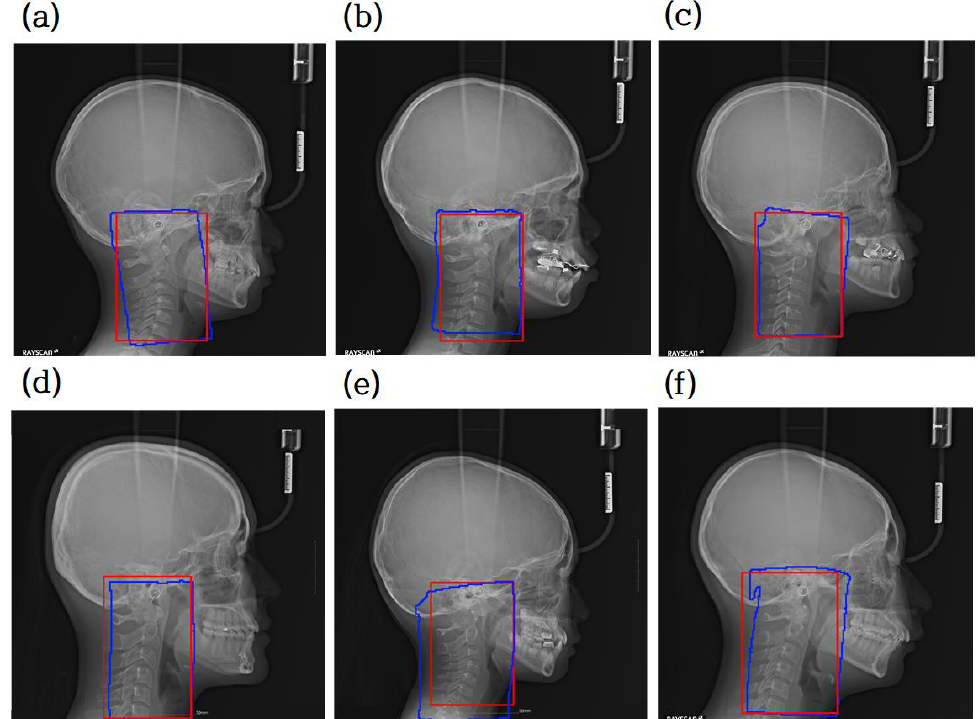
Figure 5. Comparison between ground truth of segmentation mask for extracting the region of interest (ROI) and prediction mask. Red is the ground truth, while blue is the predicted result. ( a – d ) are examples of accurate ROI detection of cervical vertebrae area. Panels ( e , f ) are not exactly tetragonal shaped, but they are necessary for the cervical vertebral region. The segmentation ground truth and the output of the segmentor are compared